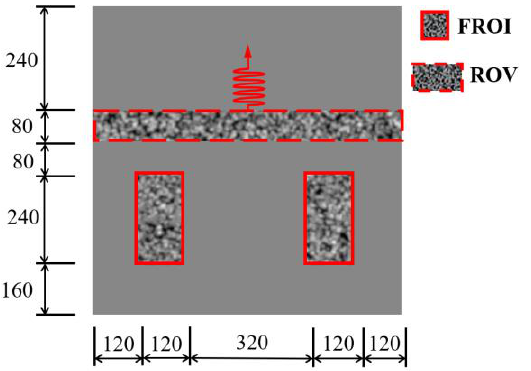
Figure 7. Video images (units: pixel).